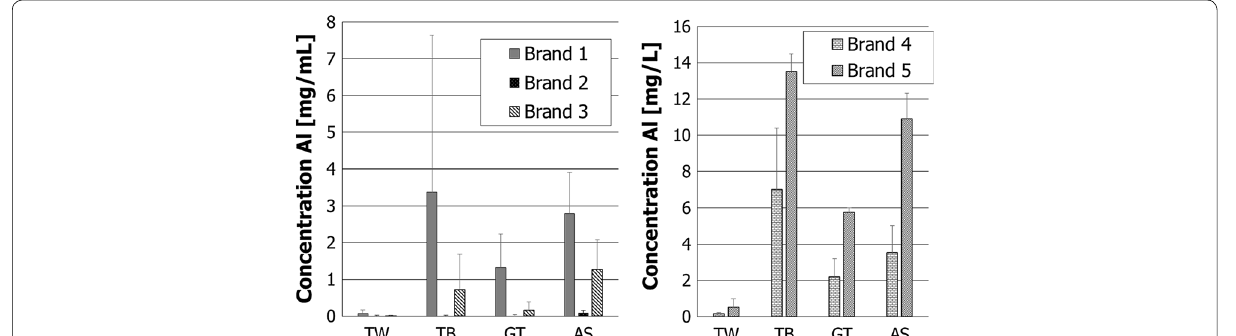
Fig. 2 Aluminum concentration in mg/L in the various drinks ( TW tap water, TB tea bag, GT granulated tea, AS apfelschorle (apple juice mixed with mineral water) after 24-h contact in lined ( left side brands 1, 2, 3 with n